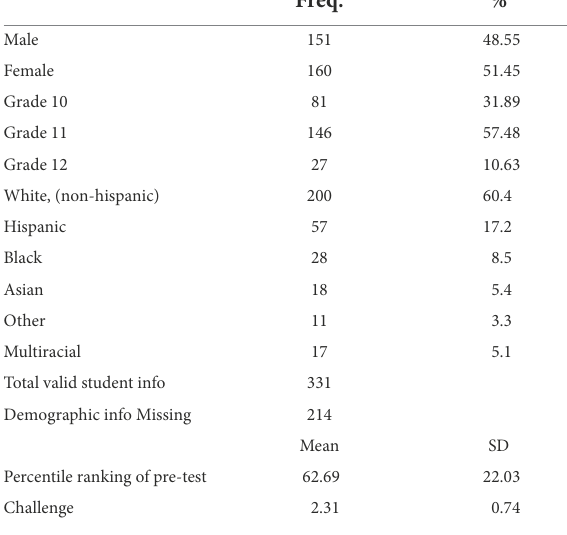
TABLE 3 Descriptive statistics of student